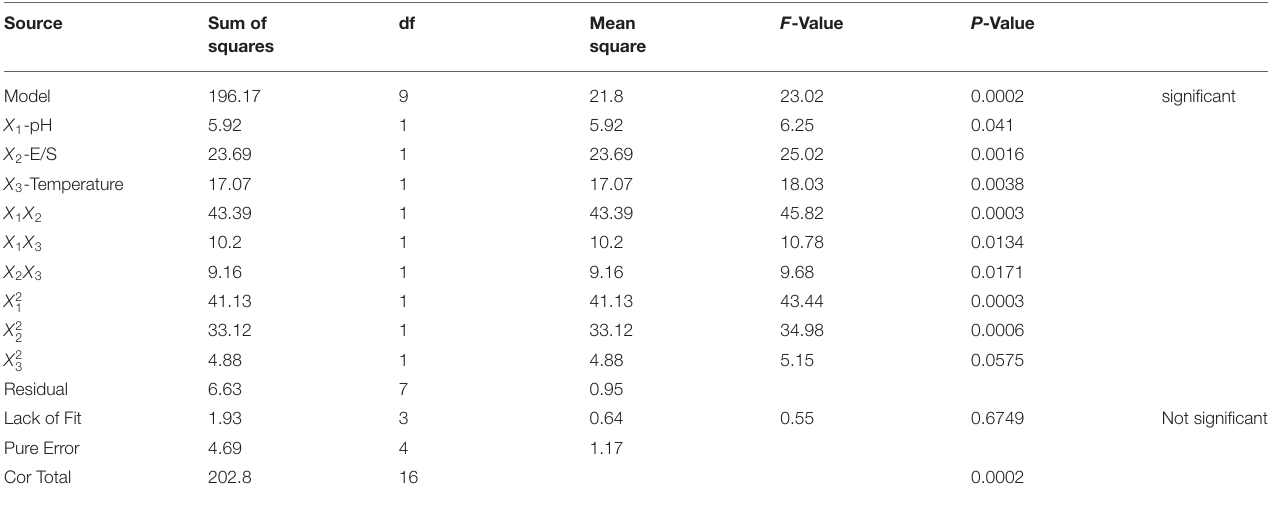
TABLE 2 | ANOVA for response surface quadratic model: estimated regression model of the relationship between dependent variables and independent variables. Source Sum of